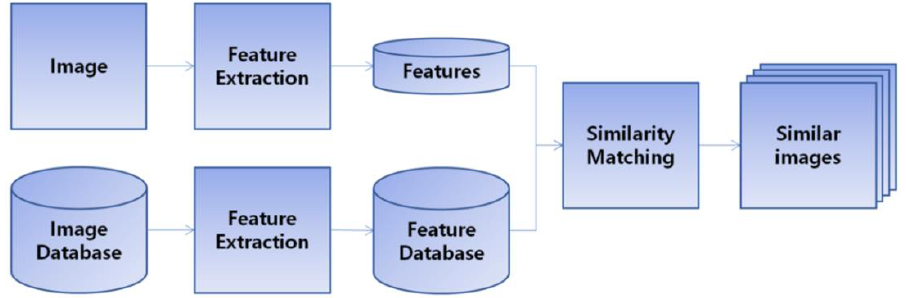
Figure 1. General content-based image retrieval framework.